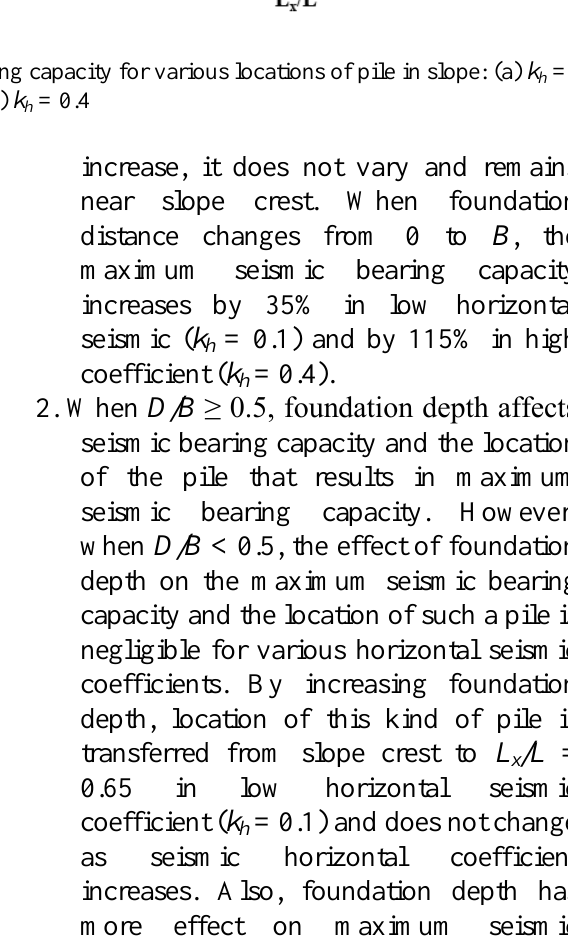
Fig. 8. Effect of foundation depth on footing seismic bearing capacity for various locations of pile in slope: (a) k